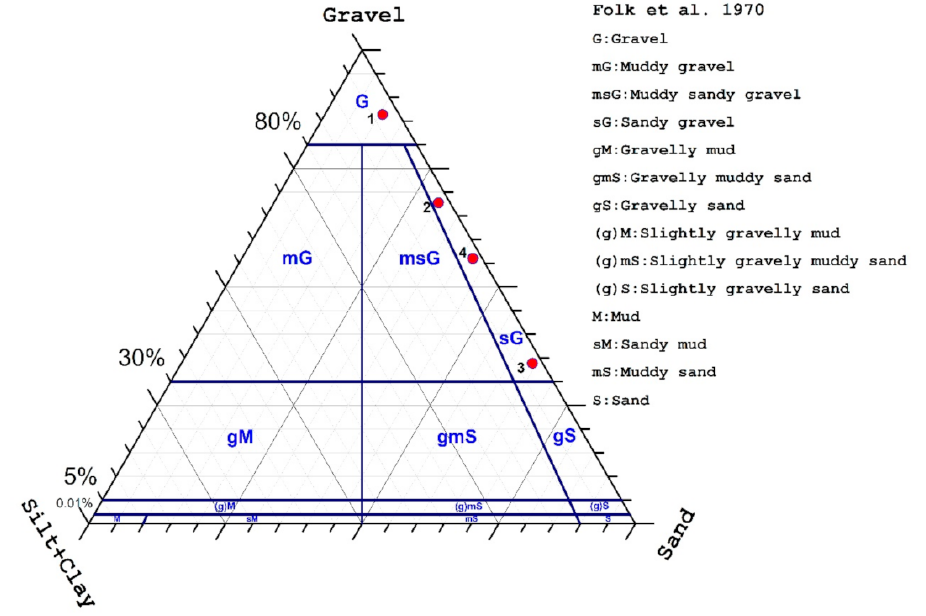
Figure 3. Lithological classification of the studied samples.